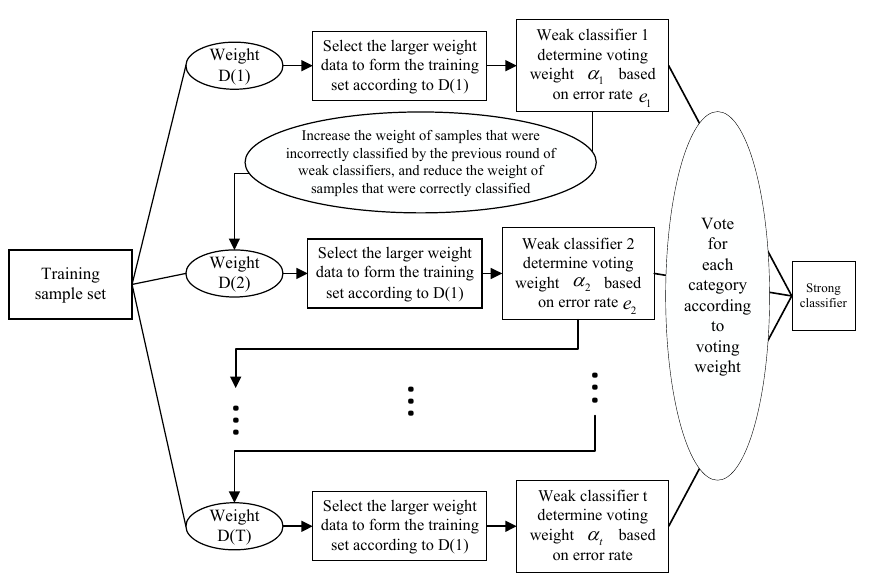
Figure 5. A flow of the AdaBoost algorithm.